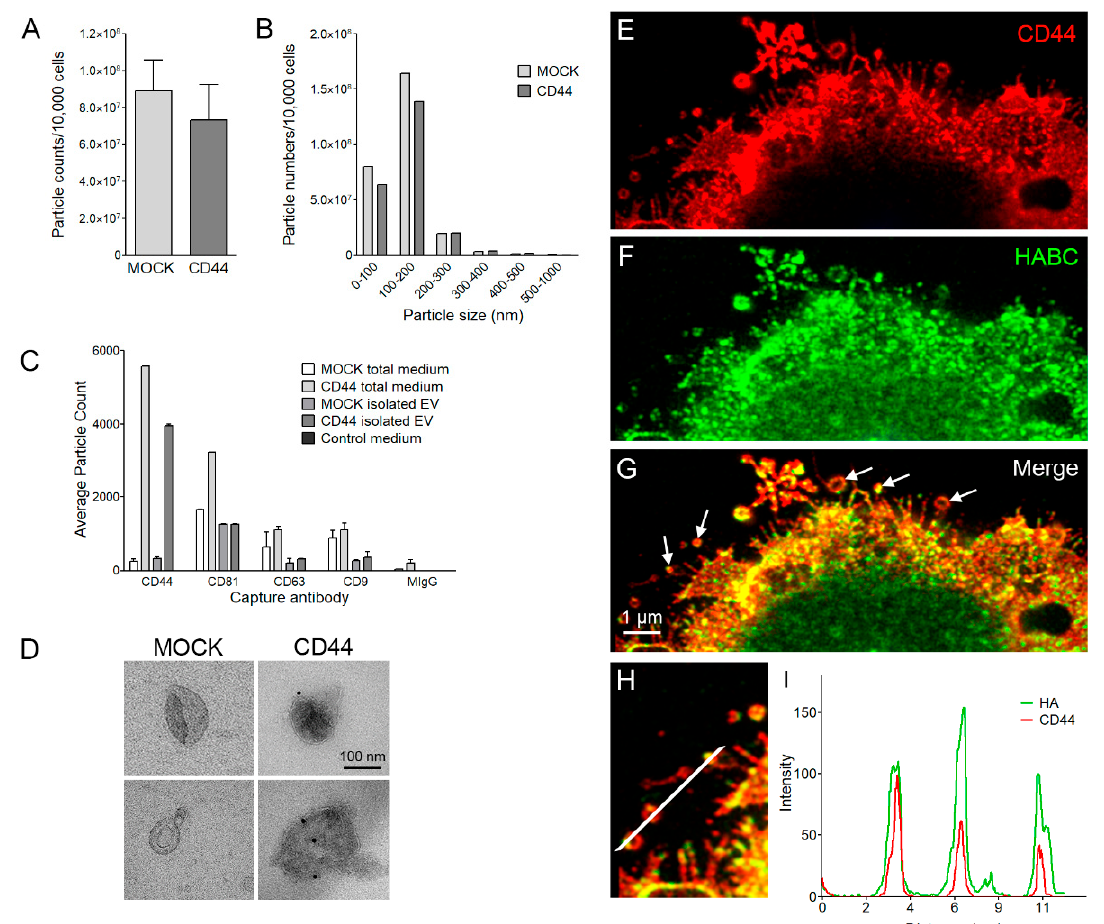
Figure 4. MKN74 cell EV secretion levels and CD44 carried by EVs. Particle counts normalized to cell